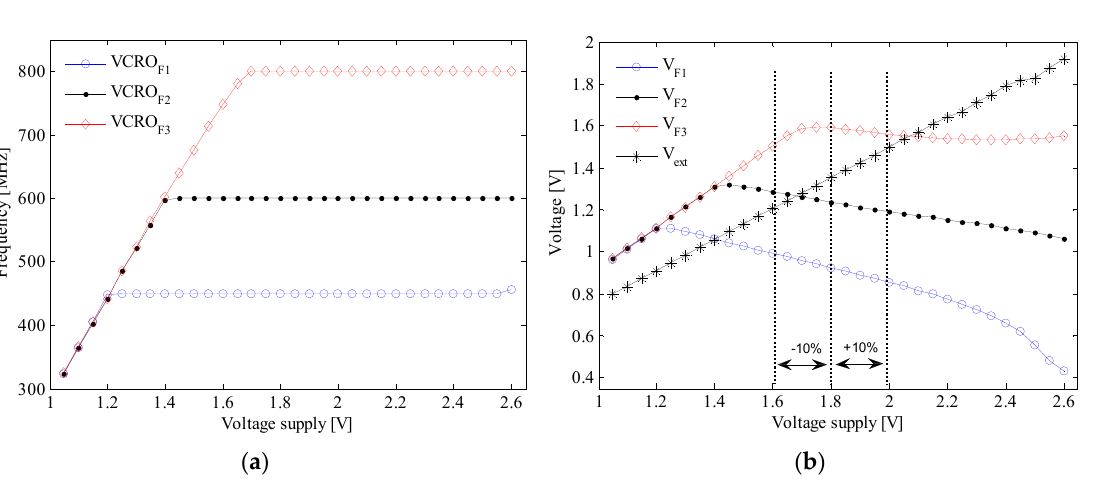
Figure 11. ( a ) Average T (cid:2912)(cid:2919)(cid:2924) dependence on VDD: with compensation (model—asterisk marker;